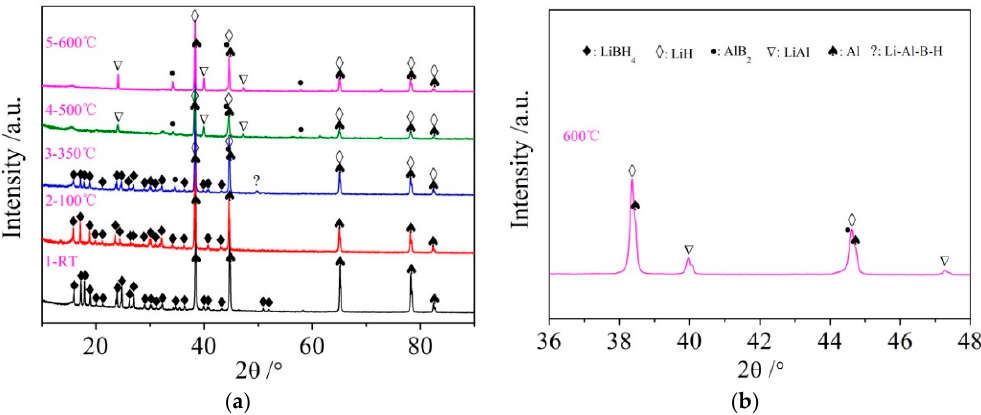
Figure 4. XRD patterns ( a ) of the LiBH 4 /Al* sample obtained at different temperatures (room temperature, 100, 350, 500, and 600 °C) and expanded XRD pattern of LiBH 4 /Al* sample of 600 °C at a 2 θ range of 36–48° ( b ).